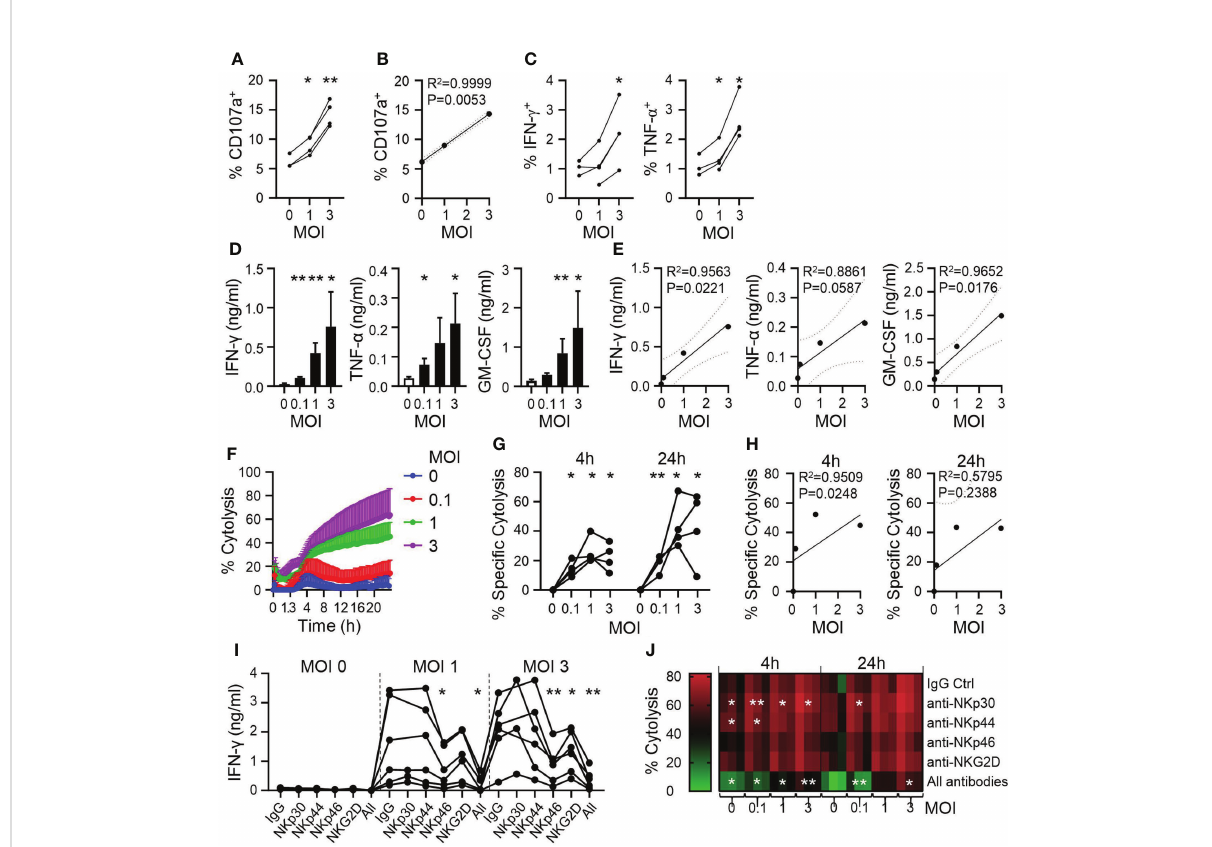
FIGURE 3 CYNK cells are activated by virus-infected cells in a dose-dependent manner. A549 cells were infected with in fl uenza A virus strain A/Puerto Rico/8/34 (PR8) at the indicated MOI and CYNK were added 24h post infection at the E:T ratio of 5:1. (A) Expression of CD107a on CYNK cells (n = 4) (B) Linear regression analysis for virus dose (x-axis: MOI) and the level of CD107 expression (y-axis). (C) The proportion of CYNK cells positive for IFN- g and TNF- a by intracellular cytokine staining after 4 hours of co-culture with virus-infected A549 cells. (n = 3-4) (D) Quanti fi cation of the indicated cytokines in cell culture supernatants collected after 24 hours of CYNK cells co-cultured with virus-infected A549 cells. (E) Linear regression analysis for virus dose (x-axis: MOI) and the level of secreted cytokine (y-axis). (F, G) Cytolysis of virus-infected A549 cells by CYNK cells analyzed using an impedance-based RTCA platform. (F) Cytolysis of virus-infected A549 by CYNK cells over 24 hours. (G) Speci fi c cytolysis of virus-infected A549 cells after CYNK at 4h and 24h of co-culture. (H) Linear regression analysis for virus dose (x-axis: MOI) and the level of speci fi c cytolysis at 4h or 24h (y-axis). (I) Quanti fi cation of IFN- g in cell culture supernatants of CYNK cells co-cultured with infected A549 cells for 24h in the presence of indicated blocking antibodies: IgG, anti-NKp30, anti-NKp44, anti-NKp46, anti-NKG2D or all (anti-NKp30, anti-NKp44 anti-NKp46, anti-NKG2D). Data pooled from two individual experiments. (J) Cytolysis of virus-infected A549 cells by CYNK cells analyzed using an impedance-based RTCA platform in the presence of indicated antibodies or the combination of all (anti-NKp30, anti-NKp44 anti-NKp46, anti-NKG2D) at 4h and 24h. Paired t-test comparing treatment control (IgG) to blocking antibodies. * indicates a statistically signi fi cant difference from IgG control in the experimental group. mean ± SD (n ≥ 3 donors). *P < 0.05, **P < 0.01. E:T, effector-to- target ratio; MOI, multiplicity of